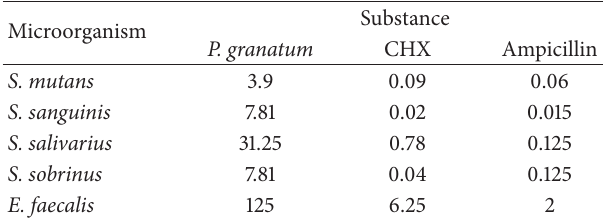
Table 2: The MIC (mg/mL) of hydroalcoholic extract of P. granatum petal, CHX, and Ampicillin for different microorganisms.